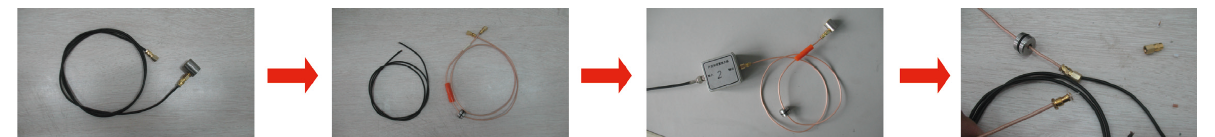
Figure 9: Sensor transmission line transformation.